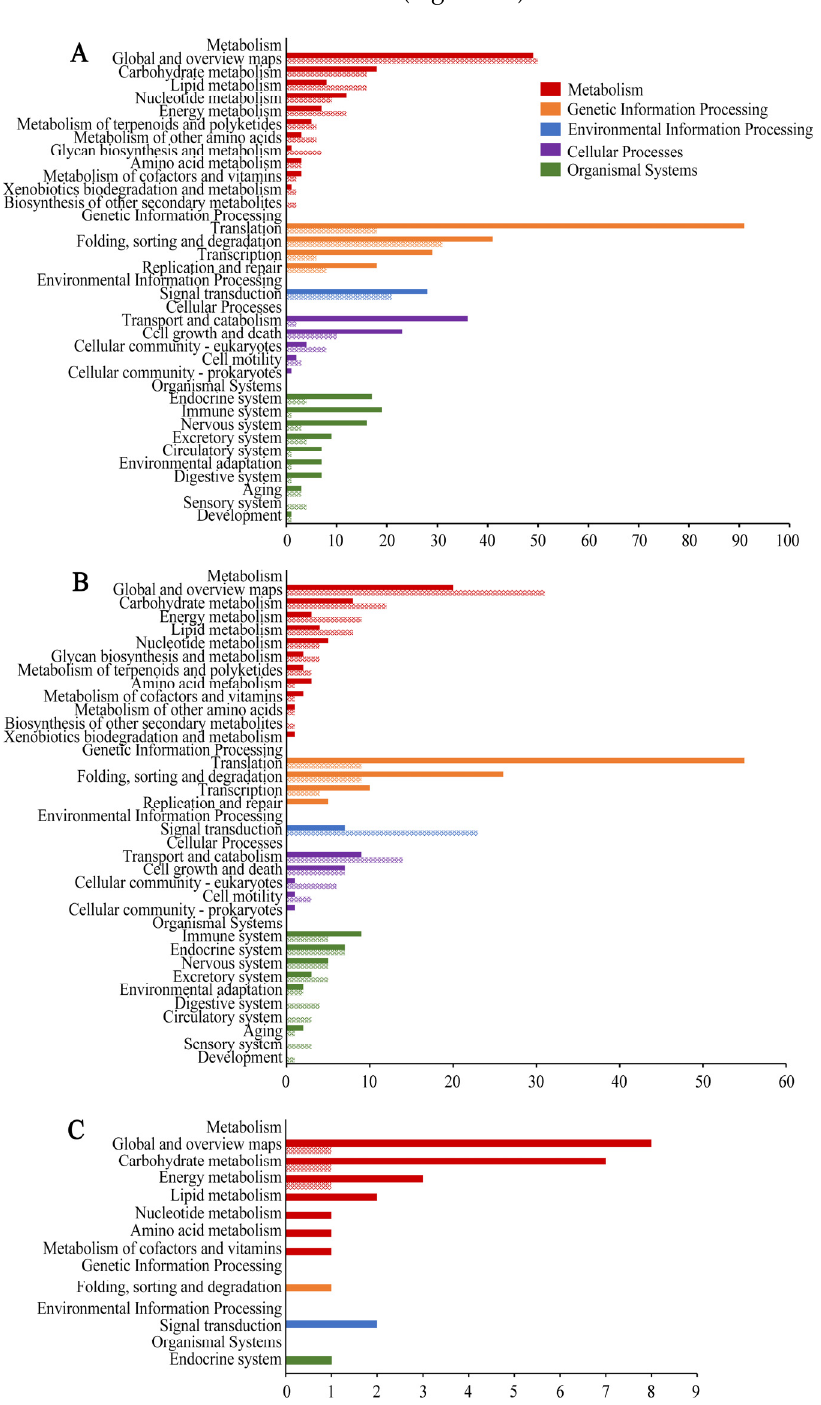
Figure 5. Pathways annotated by DEGs. ( A ) DEGs in NcCK vs. NcT1. ( B ) DEGs in NcCK vs. NcT2. ( C ) DEGs in NcT1 vs. NcT2.